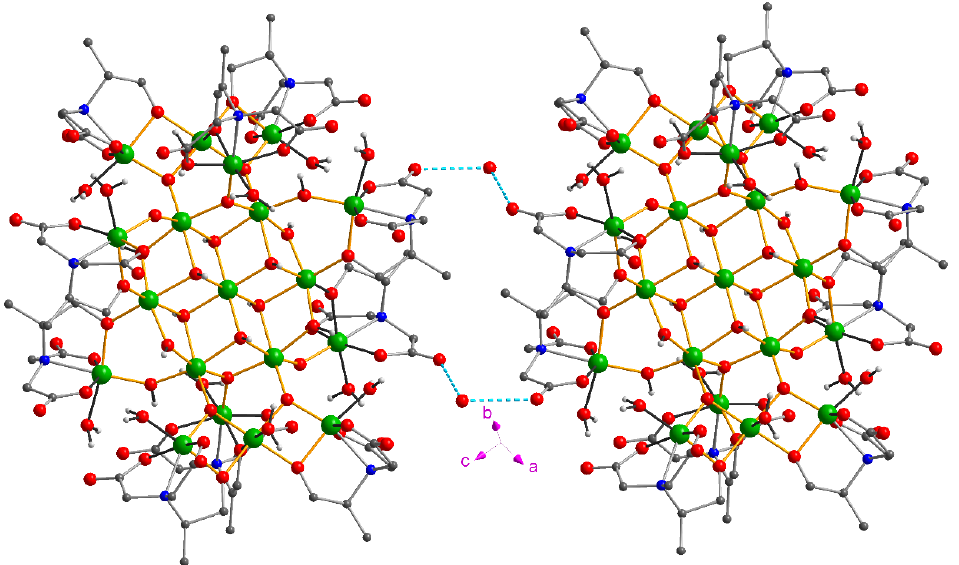
Figure A3. Intercluster hydrogen-bonding (shown as light blue dashed lines) between the Fe 19 cluster and its symmetry-equivalent at {x + 1, y, z − 1}. The simple picture that is explored here of lattice water paths dominating the inter- molecular exchange is not, however, consistent with the observed ordering. The strong AF interactions along the a direction, when taken in combination with the dipolar coupling, stabilise the (0.5 0.5 0.5) mode of ordering rather than the observed (0.5 0 0.5) mode. In- troducing the weaker lattice-water-mediated interactions along the b and a - c directions further stabilises the (0.5 0.5 0.5) mode against the actual (0.5 0 0.5) mode. We, therefore, conclude that additional direct intermolecular interactions that do not involve the lattice water also provide a significant contribution to the exchange